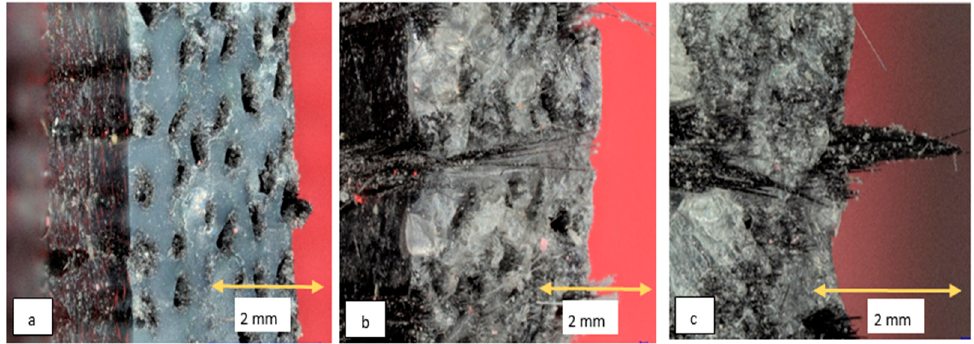
Figure 7. Microscopic image of tensile fracture surfaces. ( a ) Liqcreate Strong-X Composite, ( b ) Peopoly Nylon-Like Composite, and ( c ) Peopoly Deft Composite.